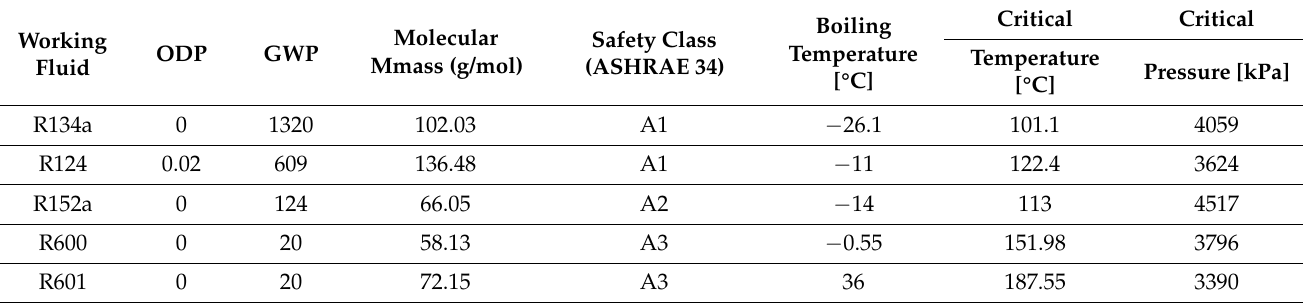
Table 11. Properties of working fluids [42–46].